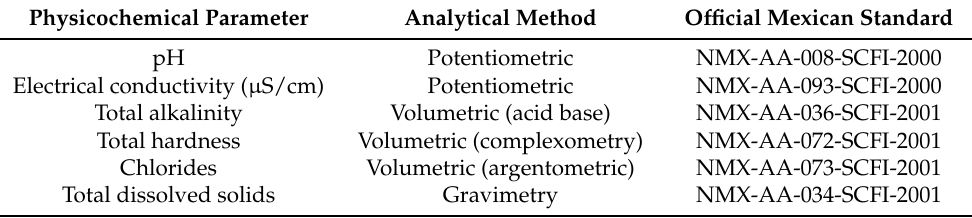
Table 2. Physicochemical parameters